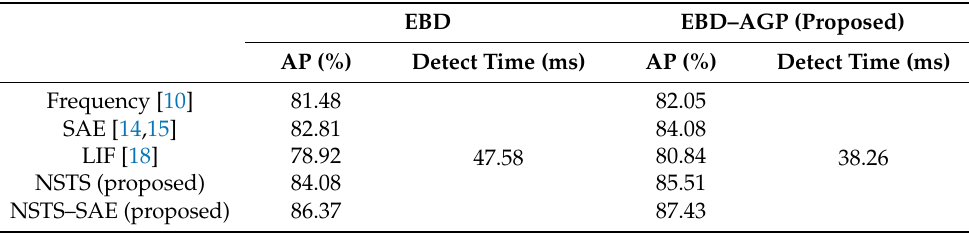
Table 4. The performance comparison of pedestrian detection accuracy and detection speed of event frames constructed by different encoding methods evaluated by EBD (event-based detector)